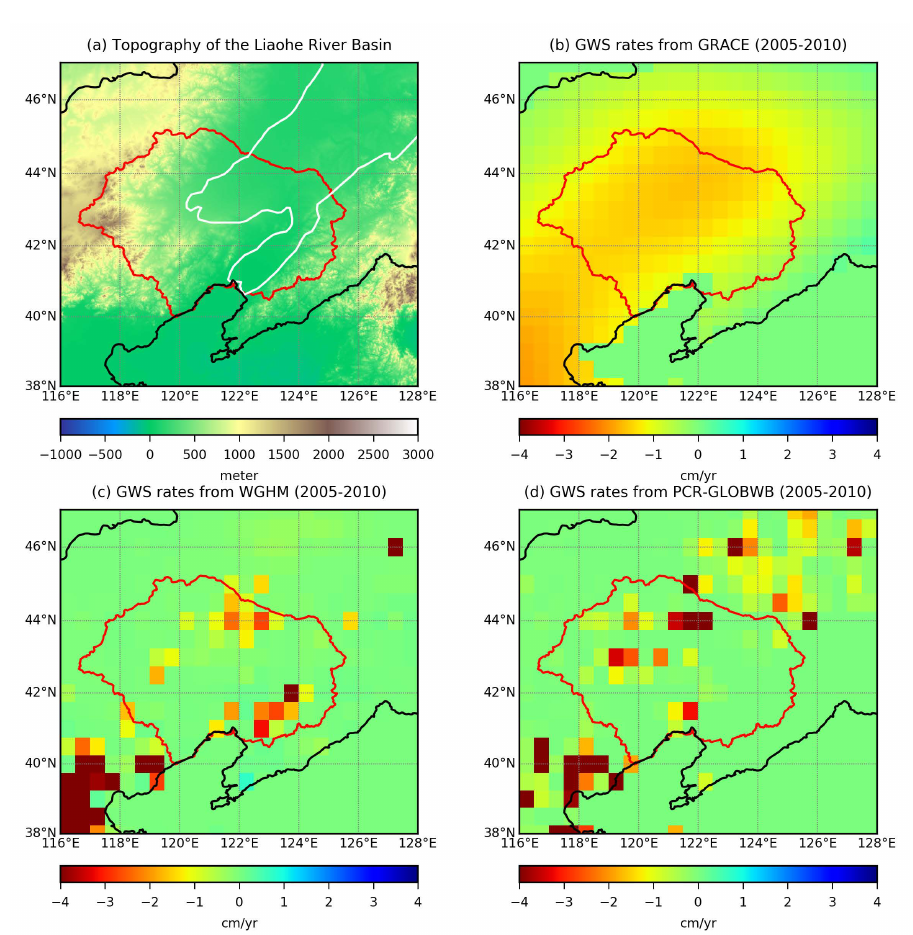
Figure 6. ( a ) Topography of the LRB and its surroundings. The red boundary outlines the basin. The white line shows the boundary of the Song-Liao Basin, same as Figure 1. Locations of three main cities in the LRB, i.e., Shenyang, Chifeng, and Tongliao, are also shown. GWS rates from ( b ) GRACE, ( c ) WGHM and ( d ) PCR-GLOBWB in the LRB and its surroundings during